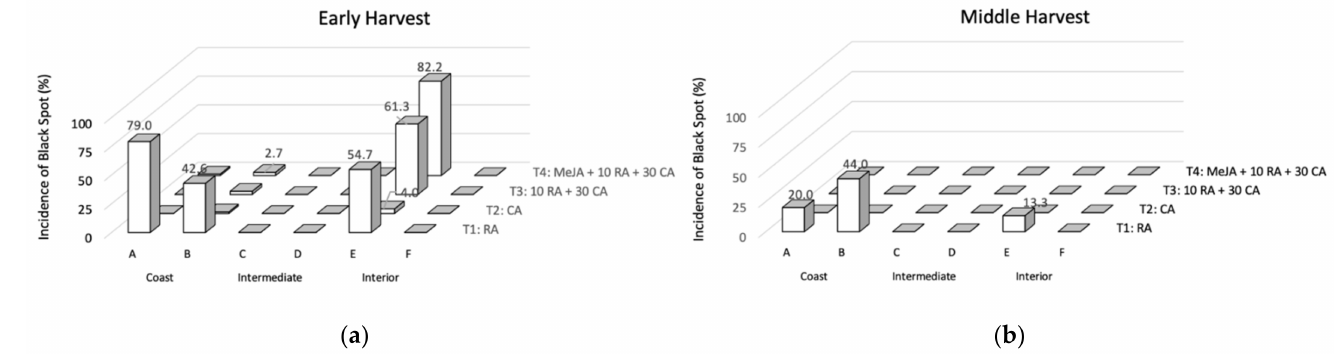
Figure 1. Evolution of the incidence of black spots for the different postharvest treatments evaluated in early ( a ) and middle ( b ) harvests in different orchards after prolonged cold storage. T1: 40 d in regular air (RA) at 5 ◦ C; T2: 40 d in a controlled atmosphere (CA) of 4 kPa O 2 and 6 kPa CO 2 at 5 ◦ C; T3: 10 d in RA at 5 ◦ C plus 30 d in CA 4 kPa O 2 and 6 kPa CO 2 at 5 ◦ C; and T4: 5 µ M MeJA plus 10 d in RA at 5 ◦ C plus 30 d in CA 4 kPa O 2 and 6 kPa CO 2 at 5 ◦ C. Table 1. Quality parameters (dry matter and firmness) of avocado fruit at harvest (before application of postharvest treatments) in orchards from the coast (A and B), intermediate (C and D), and interior (E and F)